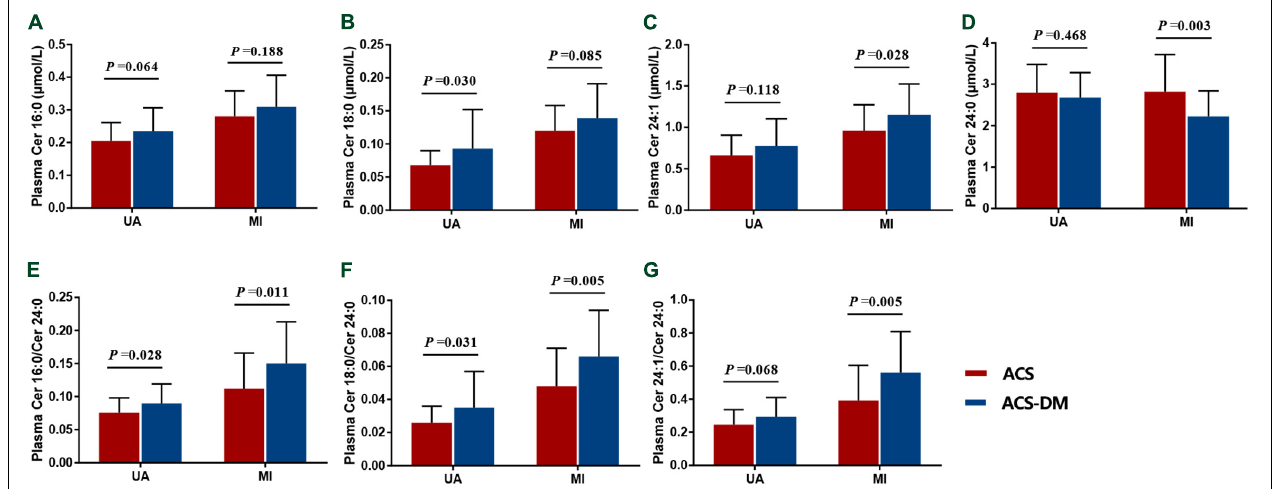
FIGURE 3 | (A–G) Subgroup analysis of the levels of ceramides in patients with acute coronary syndrome (ACS) compared with those with comorbid acute coronary syndrome and type 2 diabetes mellitus (ACS-DM). MI, myocardial infarction; UA, unstable angina.